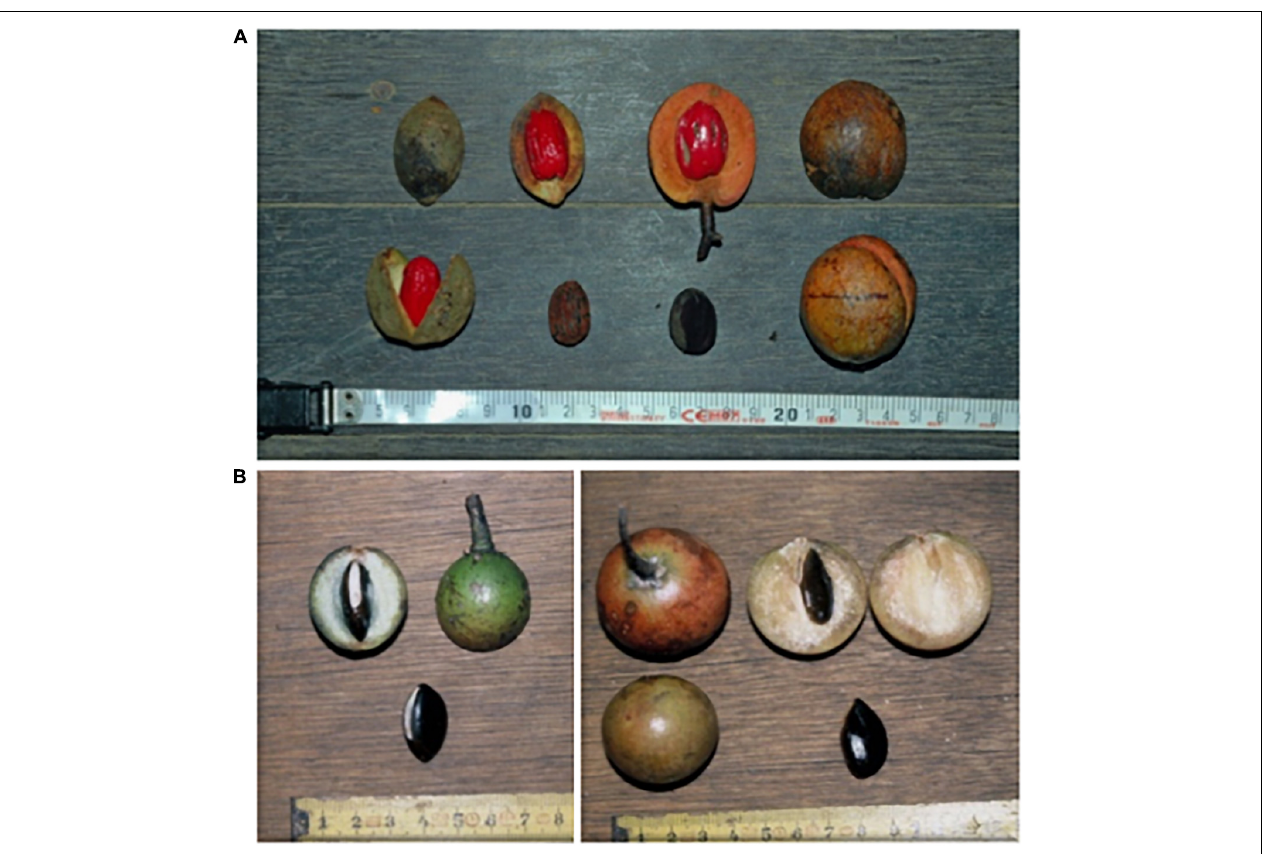
FIGURE 2 | Fruits and seeds of (A) Virola kwatae (left) and V. michelii (right), and (B) Manilkara bidentata (left) and M. huberi (right) (all photographs © Pierre-Michel